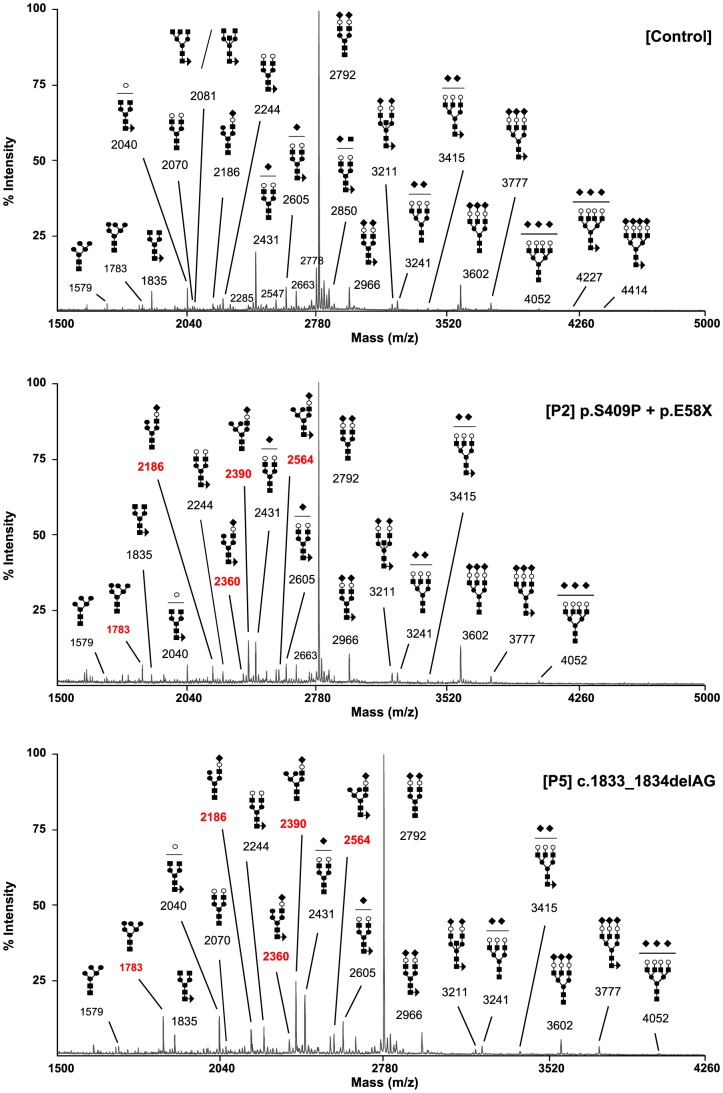
MAN1B1-deficient individuals are deficient in protein N-glycosylation.MALDI-TOF spectra of the permethylated N-glycans from sera of control and MAN1B1-deficient individuals. Respective m/z values of N-glycans structures accumulating in MAN1B1-deficient cells are displayed in red. The symbols representing sugar residues are as follows: closed square, N-acetylglucosamine; closed circle: mannose; open circle, galactose; closed diamond, sialic acid; and closed triangle, fucose. Linkages between sugar residues have been removed for simplicity.